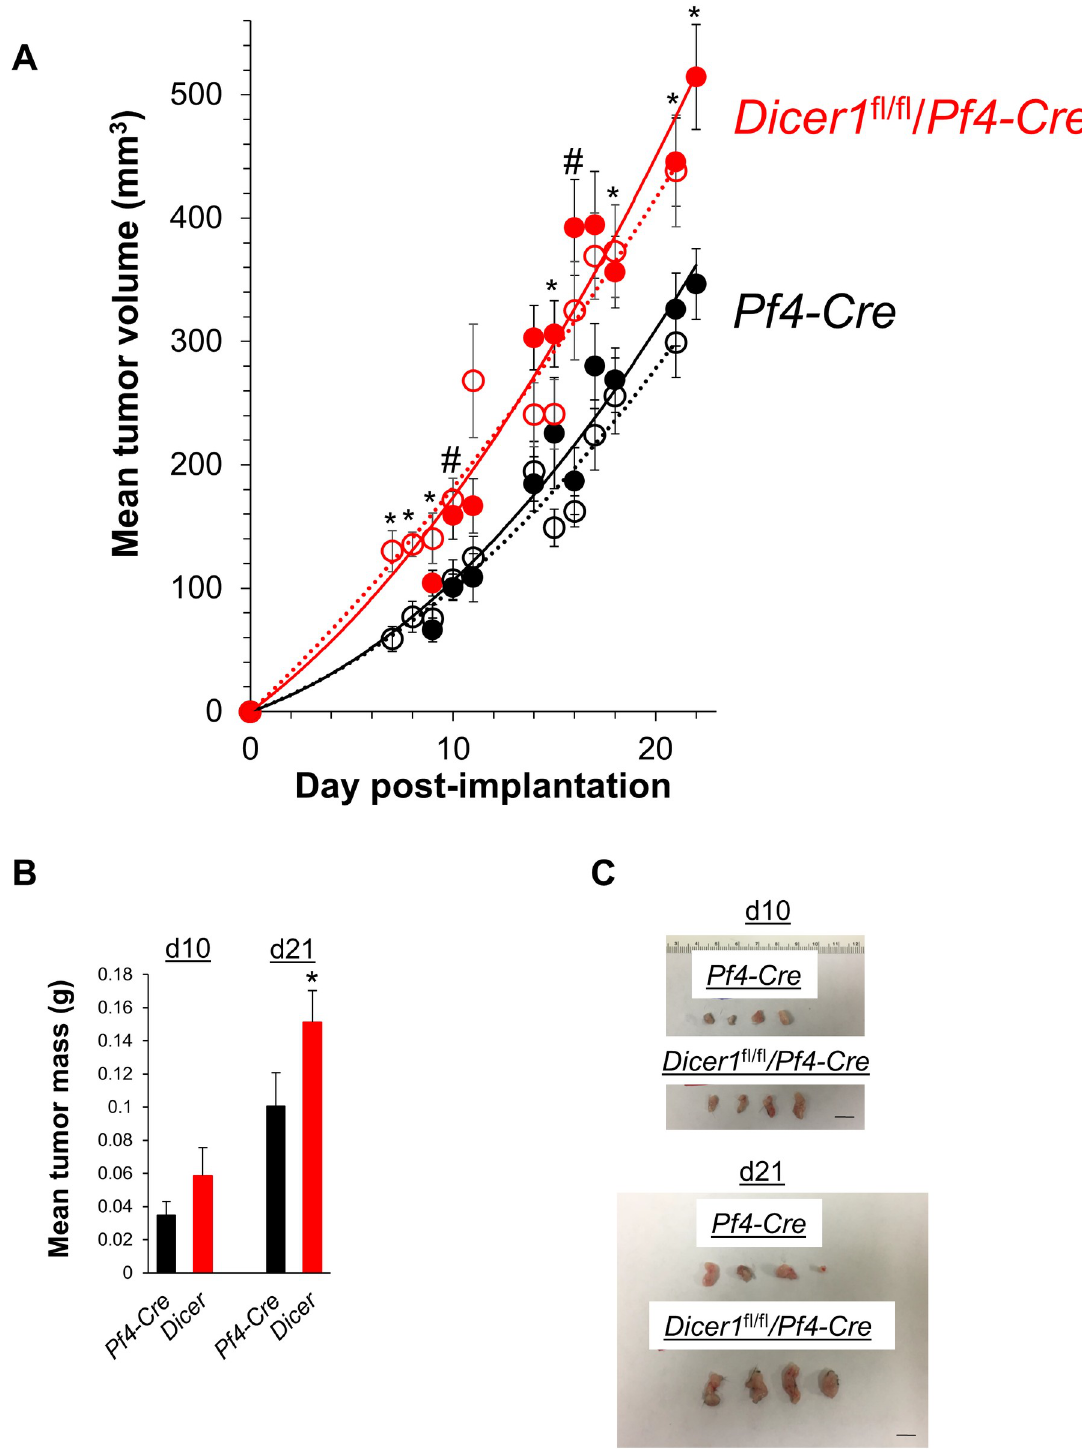
Fig 1. Platelet microRNAs suppress in vivo ectopic solid tumor growth in mice. A KPC ectopic primary tumor growth measured by calipers. Average volumes from twelve tumors per type per experiment are shown at each time point ± s.e.m. Solid and dotted line pairs represent independent experiments. Experiment 2 (solid lines) concluded at 22 days post-implantation, as shown. B Masses of primary tumors isolated at the indicated times ( n = 12). Representative data are shown + s.e.m. from one of four independent experiments. C Representative resected tumors. Bar, 1 cm. � , p < 0.05; #, p < 0.02.